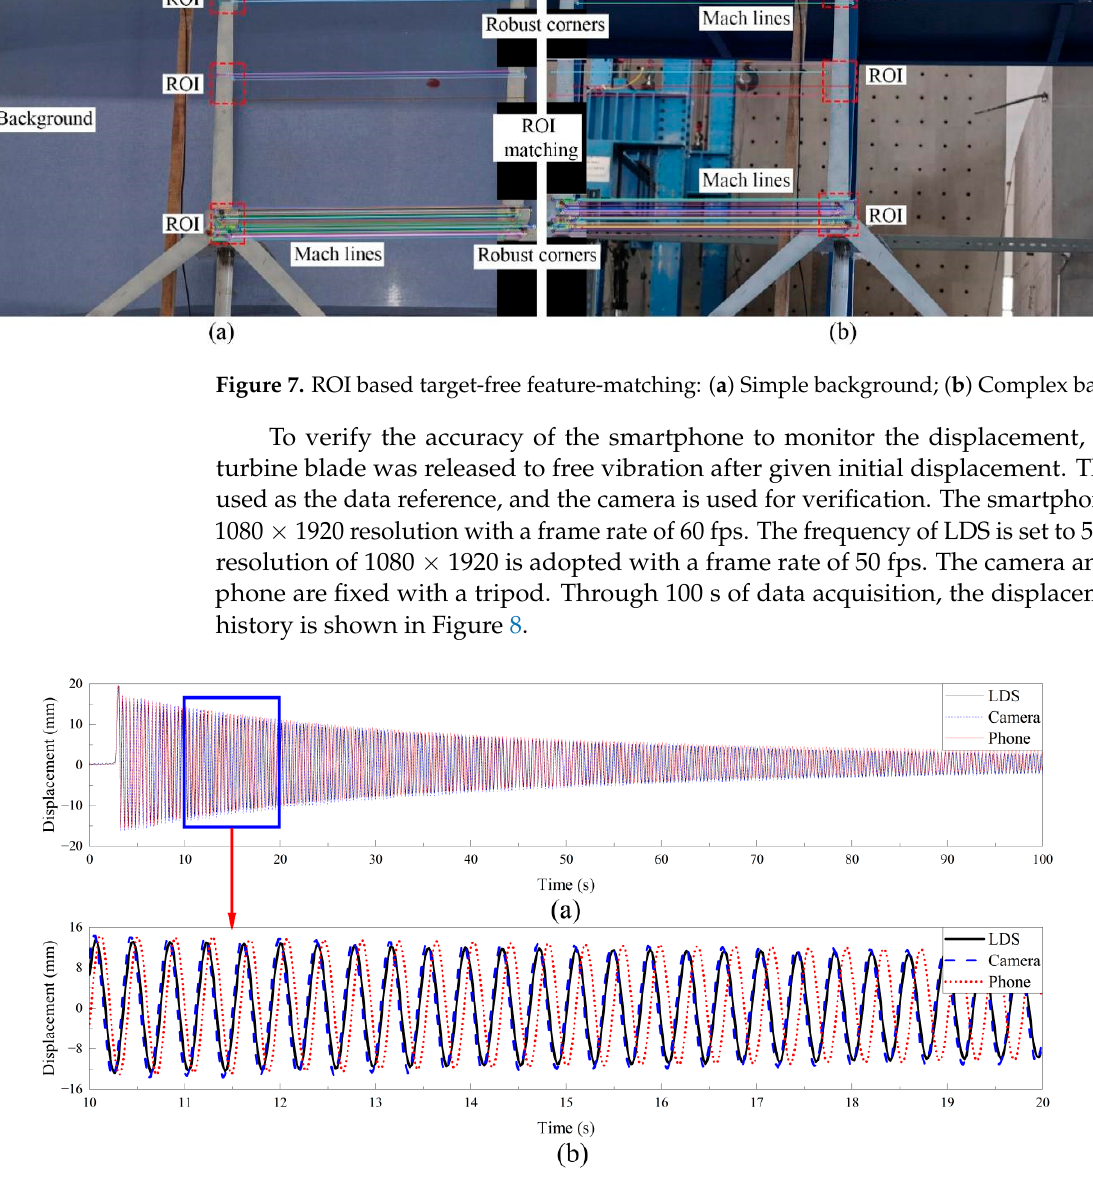
Figure 8. Time history comparison of vibration displacement monitored by smartphones: ( a ) Whole displacement time history; ( b ) 10~20 s displacement time history.